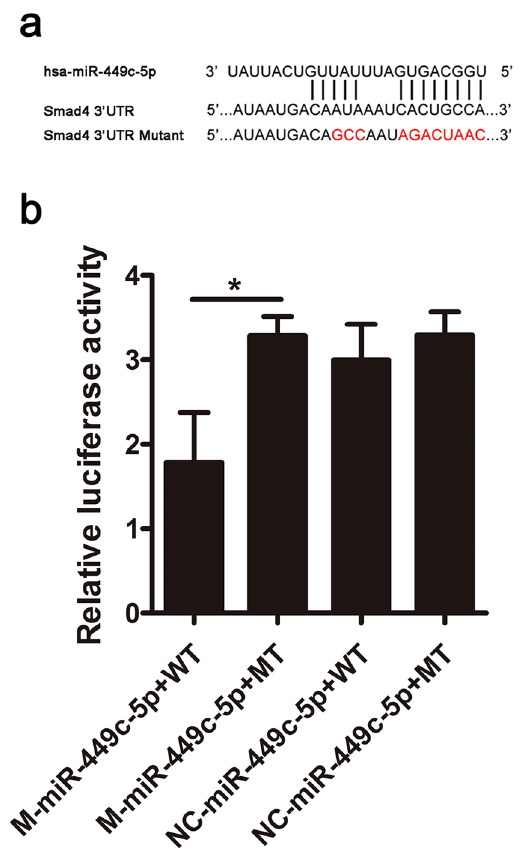
Figure 4. MiR-449c-5p directly targets Smad4. ( a ) Schematic of the putative miR-449c-5p target site in human Smad4 3 ′ -UTR and the eleven mutated nucleotides are colored red. ( b ) Dual-luciferase assay after transfection of M-miR-449c-5p, NC-miR-449c-5p with wild-type Smad4 3 ′ -UTR or mutant Smad4 3 ′ UTR. n = 3 in each group. Data are presented as the mean ± SD. * P <